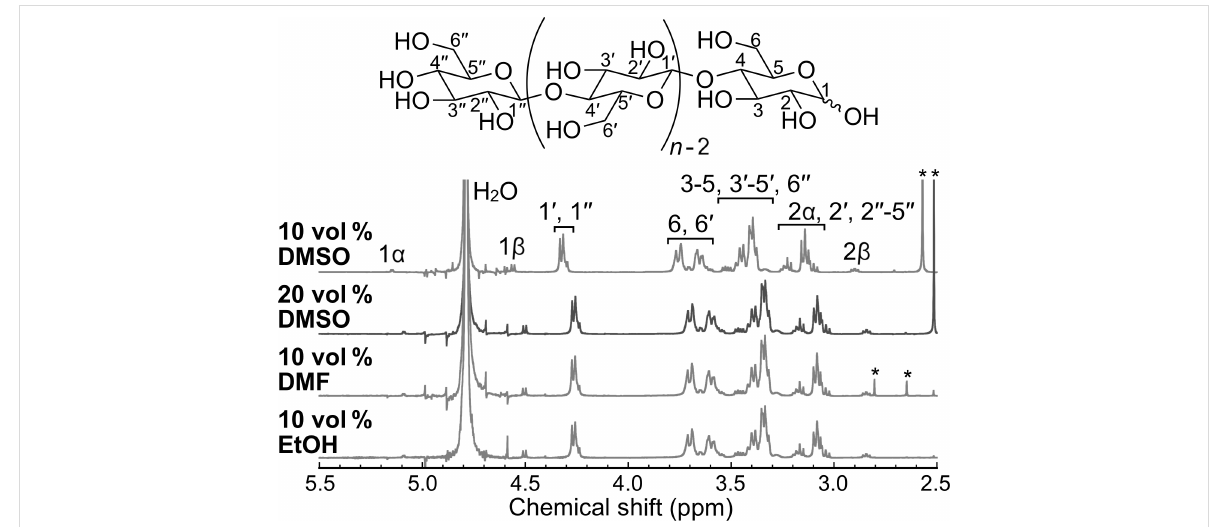
Figure 5: 1 H NMR spectra of the products with DMSO, DMF, and EtOH. The peaks with * are derived from the residual organic solvents.